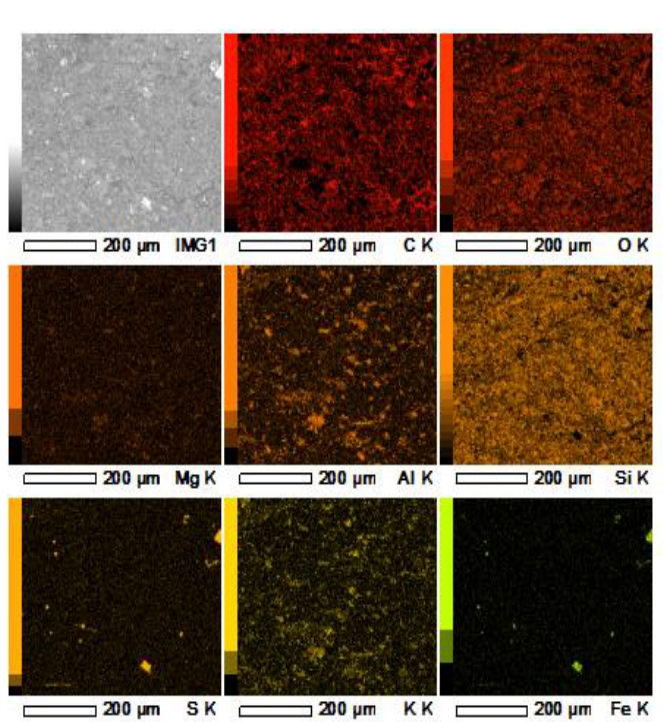
Figure 4. Elemental maps (C, O, Mg, Al, Si, S, K, Fe) of shungite, obtained via scanning electron microscopy and energy-dispersive X-ray spectroscopy.